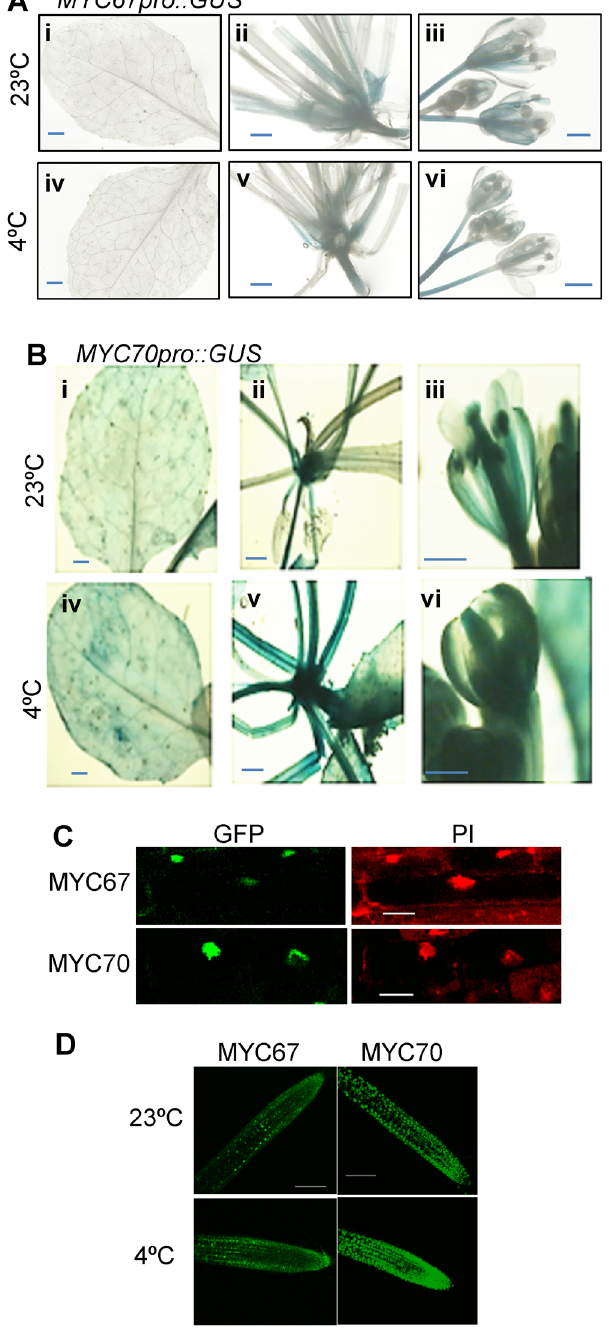
Figure 5. Expression and localization of MYC67 and MYC70 . ( A ) Six-week-old plants expressing MYC67pro:GUS was treated without (i–iii) or with (iv–vi) low temperature for 6 h. MYC67pro:GUS expression in mature rosetta leaves (i,iv), base of rosetta leaves (ii, v), and floral organs (iii,vi). ( B ) Six-week-old plants expressing MYC70pro:GUS was treated without (i–iii) or with (iv–vi) low temperature for 6 h. MYC70pro:GUS expression in mature rosetta leaves (i, iv), base of rosetta leaves (ii,v), and floral organs (iii, vi). ( C ) Subcellular localization of the GFP-MYC proteins. The nuclei were stained with 20 mg/ml PI. The scale bar indicates 20 μ m. ( D ) GFP fluorescence at the root tips. Seven-day old seedlings were treated at 4 °C for 3 h, and GFP fluorescence was observed by confocal microscopy. The scale bar indicates 150 μ